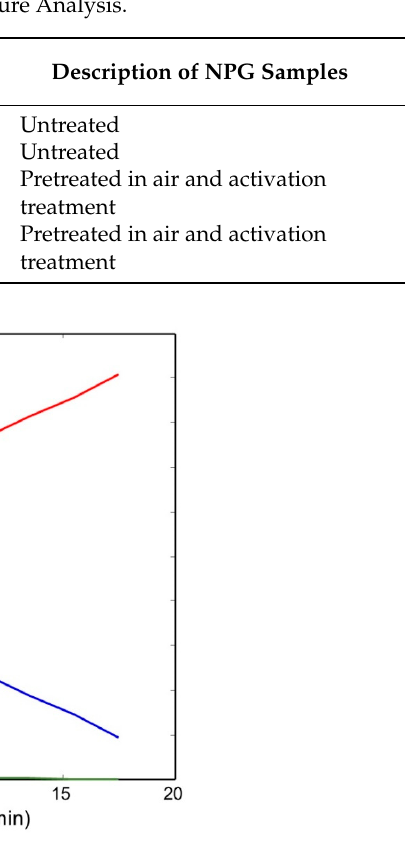
Figure 11. Atomic concentration depth profile of Ni and O for pretreated and activated getter d-sample.